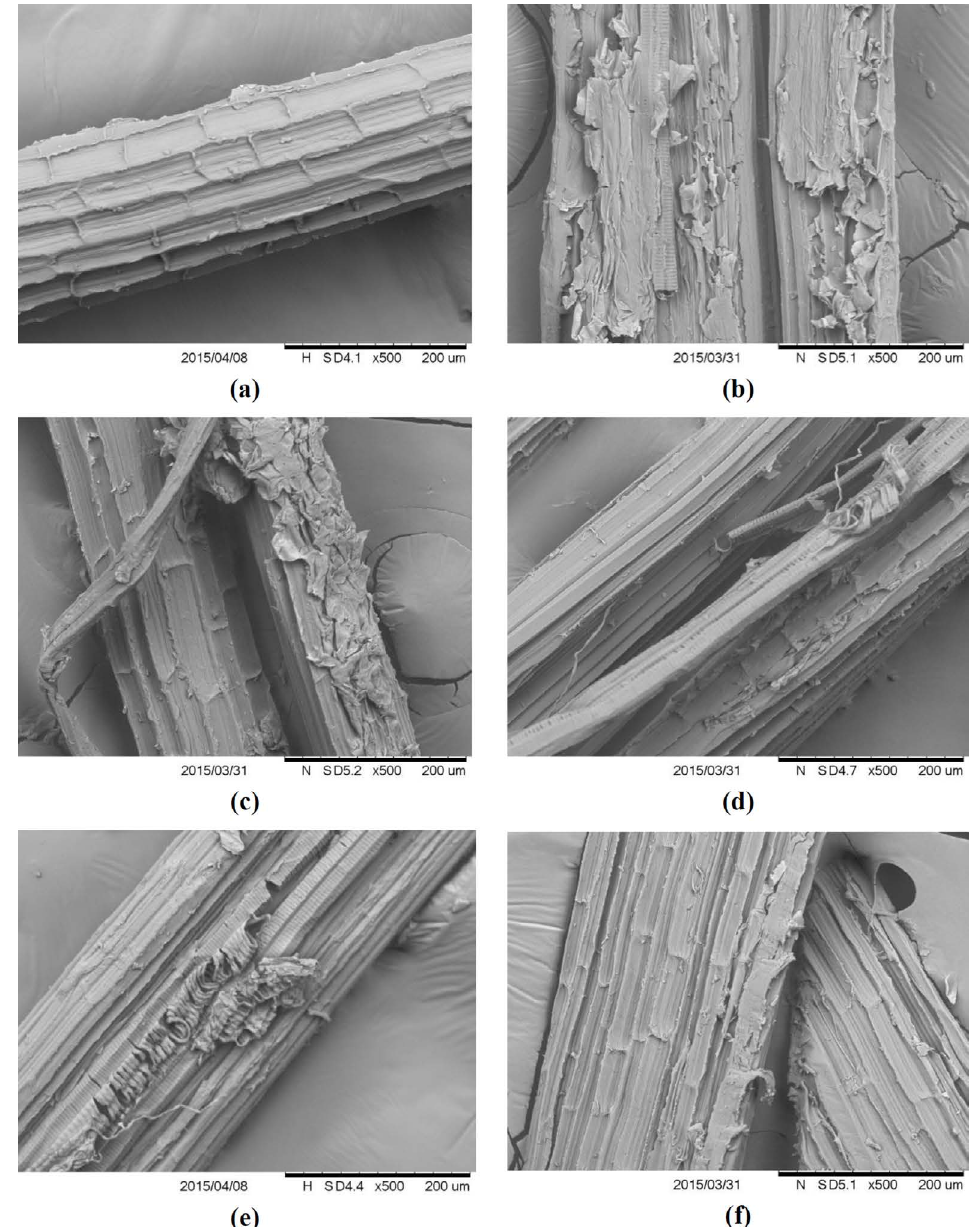
Figure 8. (a) Natural sisal fibre, (b) modified fibre with lauroyl chloride and DMF, (c) modified fibre with stearoyl chloride and toluene, (d) modified fibre with stearoyl chloride and DMF, (e) modified fibre with octanoyl chloride and toluene, and (f) modified fibre with octanoyl chloride and